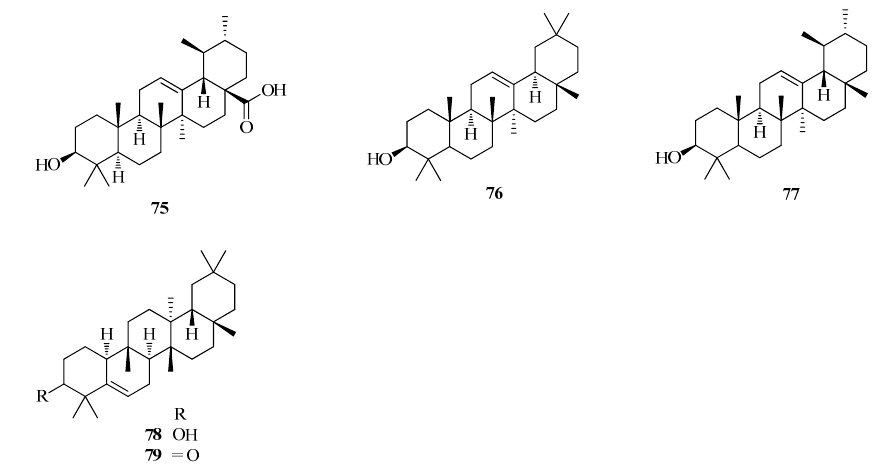
Figure 5. Structures of triterpenoids isolated from F. esculentum , F. tataricum and F. diabotrys .